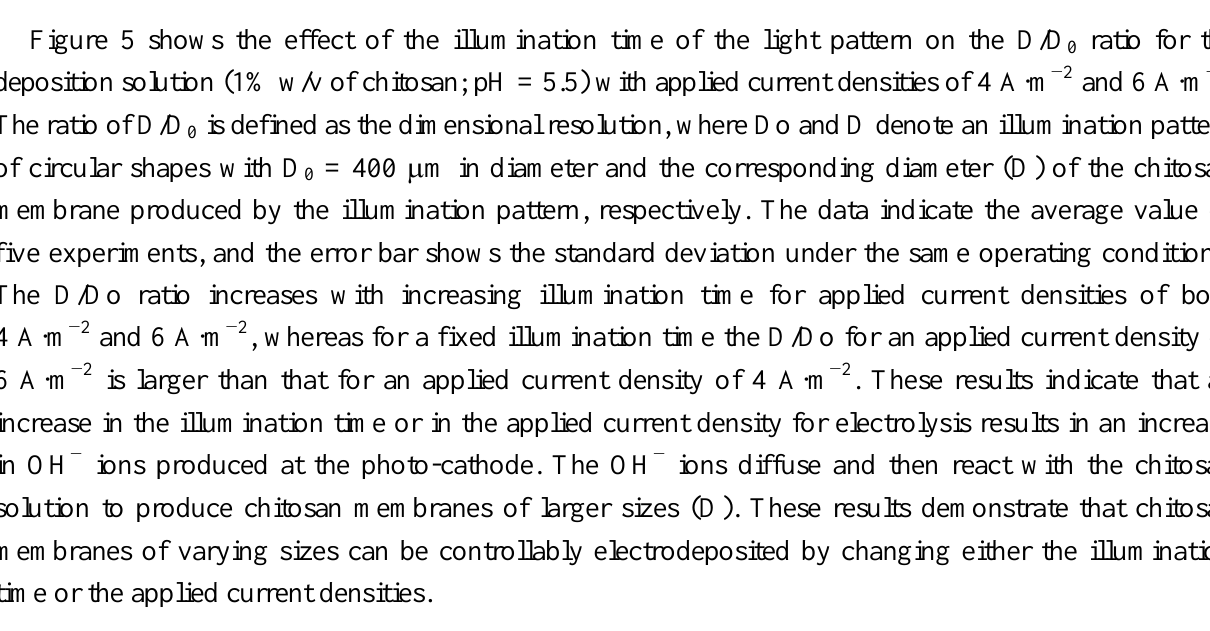
Figure 5. The effect of the illumination time of the light pattern on the dimensional resolution (D/D ) for a deposition solution (1% w/v of chitosan; pH = 5.5) with applied 0 current densities of 4 and 6 A·m −2 . (D and D denote the illumination pattern of circular 0 shapes with D = 400  m in diameter and the corresponding diameter (D) of the chitosan 0 membranes produced by the illumination